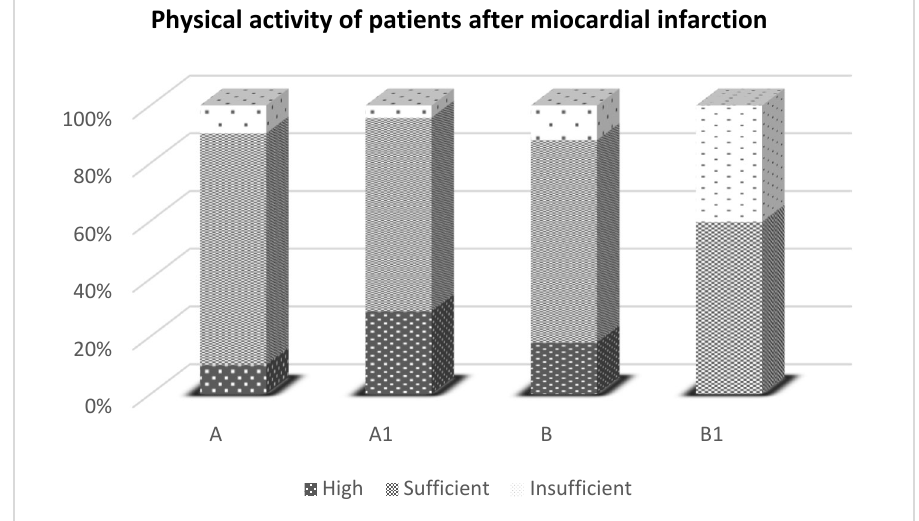
Figure 1 . The level of physical activity of the examined patients after myocardial infarction assessed by the International Physical Activity Questionnaire. Explanation abbreviations: A—Studied group of patients after myocardial infarction before rehabilitation, A1—Studied group of patients after myocardial infarction and rehabilitation, B—Studied group patients after myocardial infarction who did not participating in rehabilitation, B1—Examined a group of patients after myocardial infarction and 3 weeks without rehabilitation.